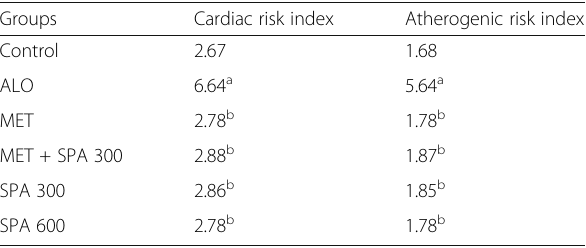
Table 3 Effect of methanol extract of S. sparganophora leaves on cardiovascular disease index in alloxan-induced diabetic rats Groups